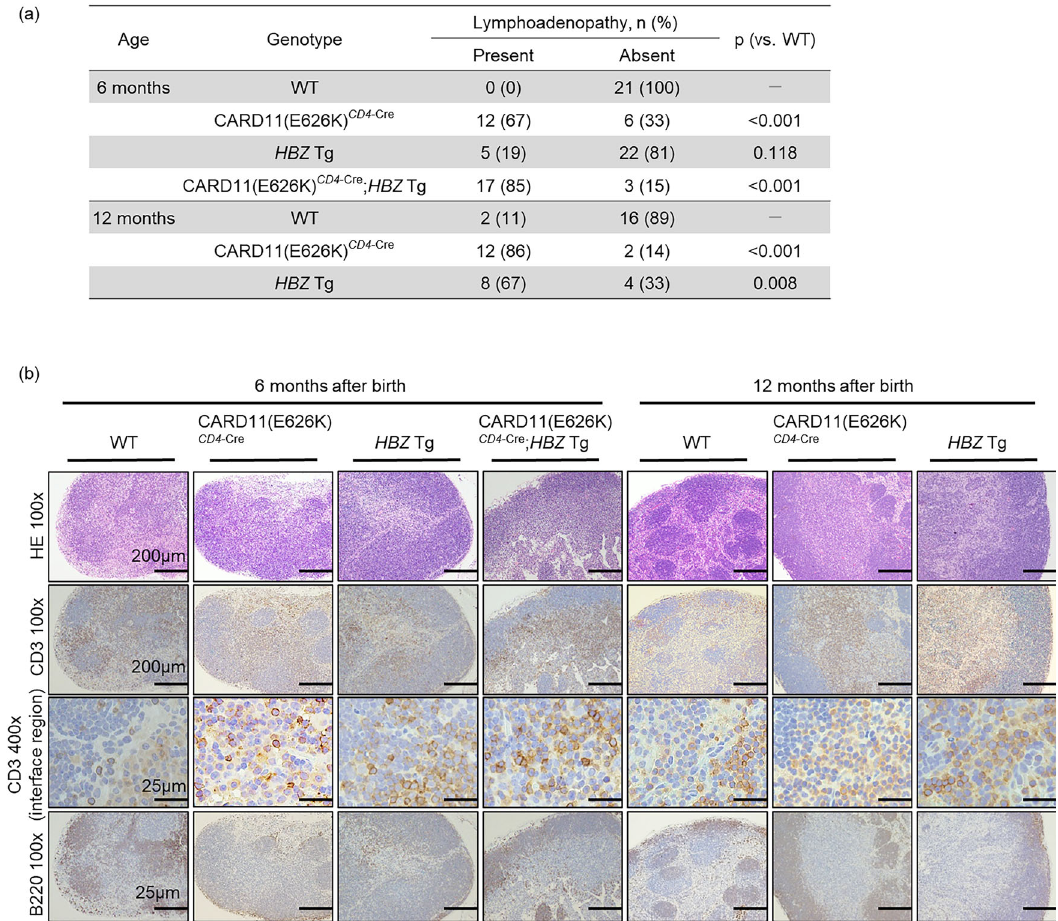
Fig. 3 Lymphadenopathy and disruption of lymph node architecture in mutant mice. a The frequency of lymphadenopathy at 6 and 12 months after birth. Swollen lymph nodes (LNs) are not large, with a mean diameter of about 3 mm. Differences between frequencies of lymphadenopathy were assessed by Fisher ’ s exact test with Benjamini – Hochberg correction. b Histologic analysis of LNs at 6 and 12 months after birth ( n = 5 for each mouse type). LNs were stained with hematoxylin and eosin (HE), and anti-CD3 and anti-B220 antibodies. The interface between the cortex and paracortex is shown with high magni fi cation (CD3